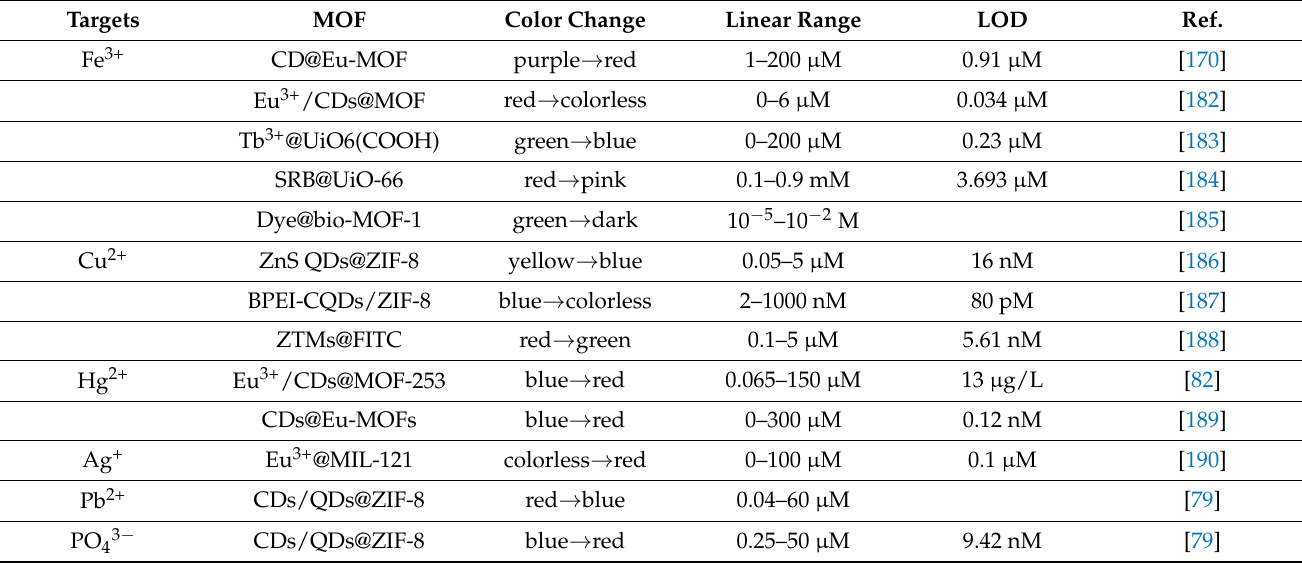
Table 2. Performances of MOF-based fluorescent chemosensors for the detection of inorganic ions.